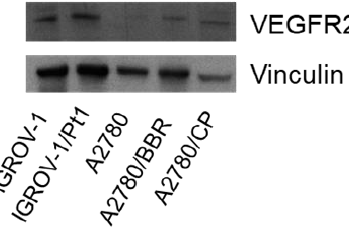
Figure 2. Western blot analysis of VEGFR2 levels in different ovarian carcinoma cell lines. Western blot analysis was carried out in ovarian carcinoma exponentially growing cells. Control loading is shown by vinculin. One experiment representative of three is reported. For whole Western blot analysis of VEGFR2 levels and band intensities quantification of VEGFR2 levels in different ovarian carcinoma cell lines, see Figure S3 and Table S1, respectively.